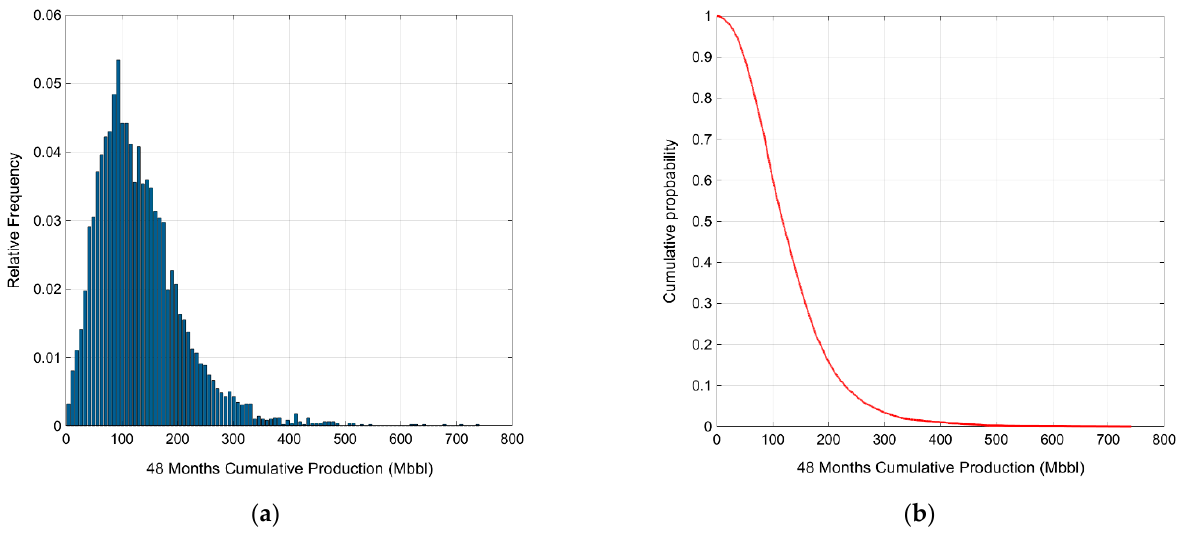
Figure 26. Probabilistic results of the total wells using the Arps hyperbolic for 48 months: ( a ) Histogram; ( b ) the cumulative probability distribution.